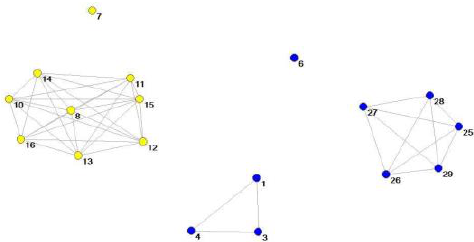
Fig.10. The deconstruction of Marc's network, stage